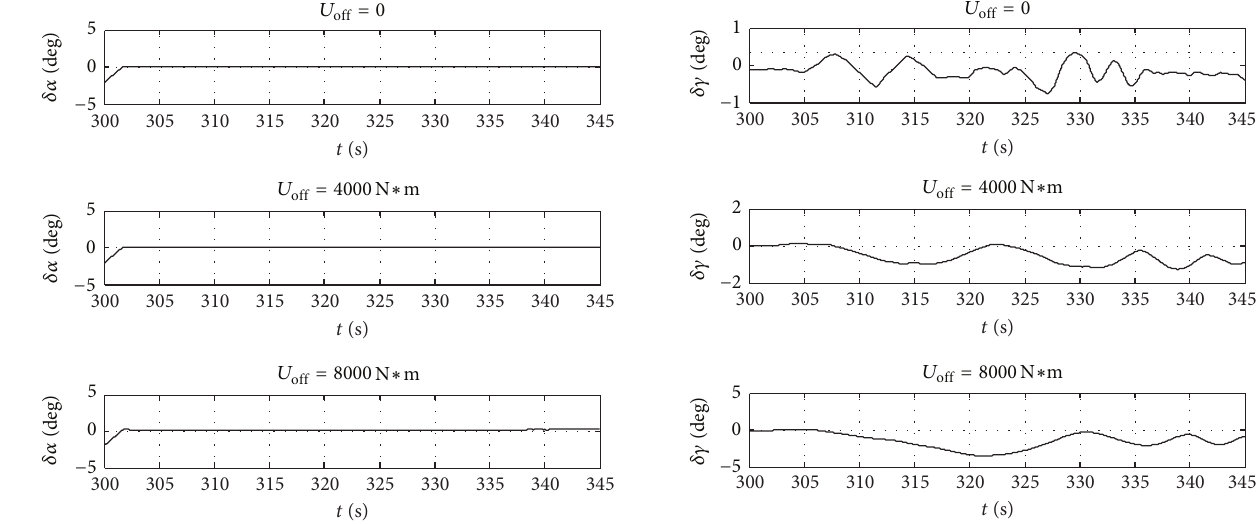
Figure 27: Simulation result of roll angle